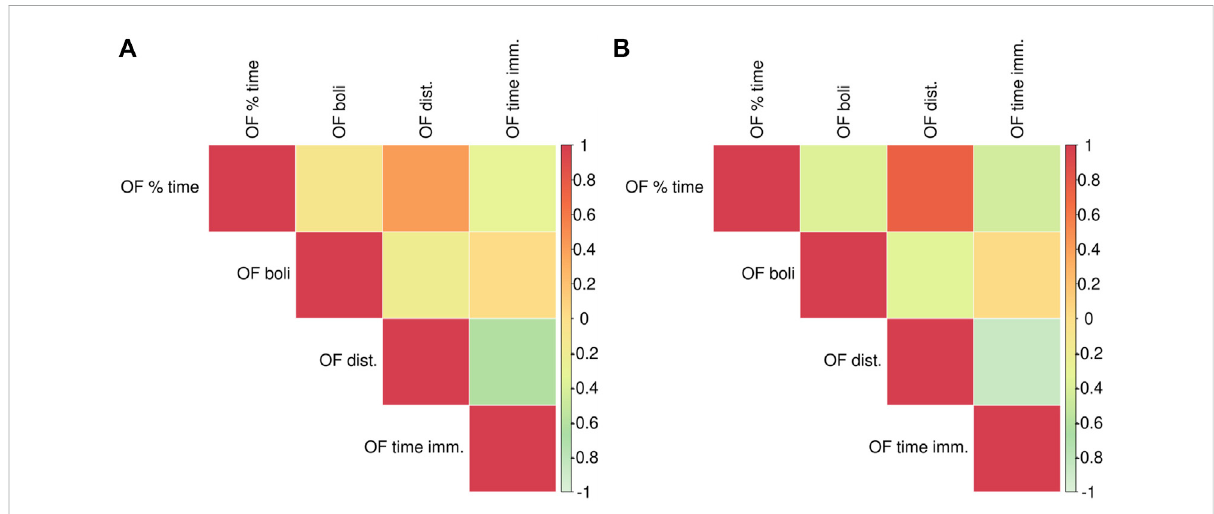
FIGURE 6 Phenotypic and genetic correlations between OF traits. Phenotypic correlations are depicted in panel (A) , genetic correlations are in panel (B) . Phenotypic and genetic correlation estimates as well as the p -values are listed in Supplementary Table